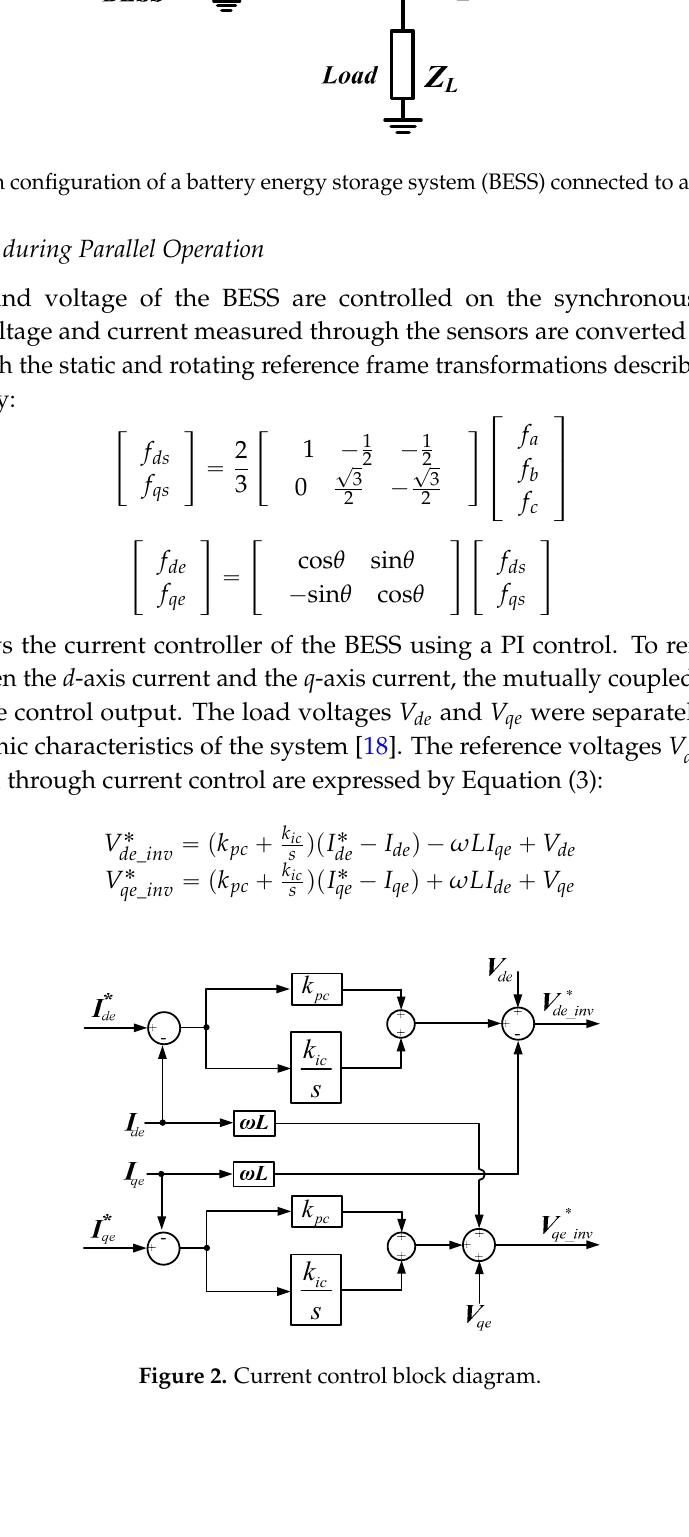
Figure 2. Current control block diagram.